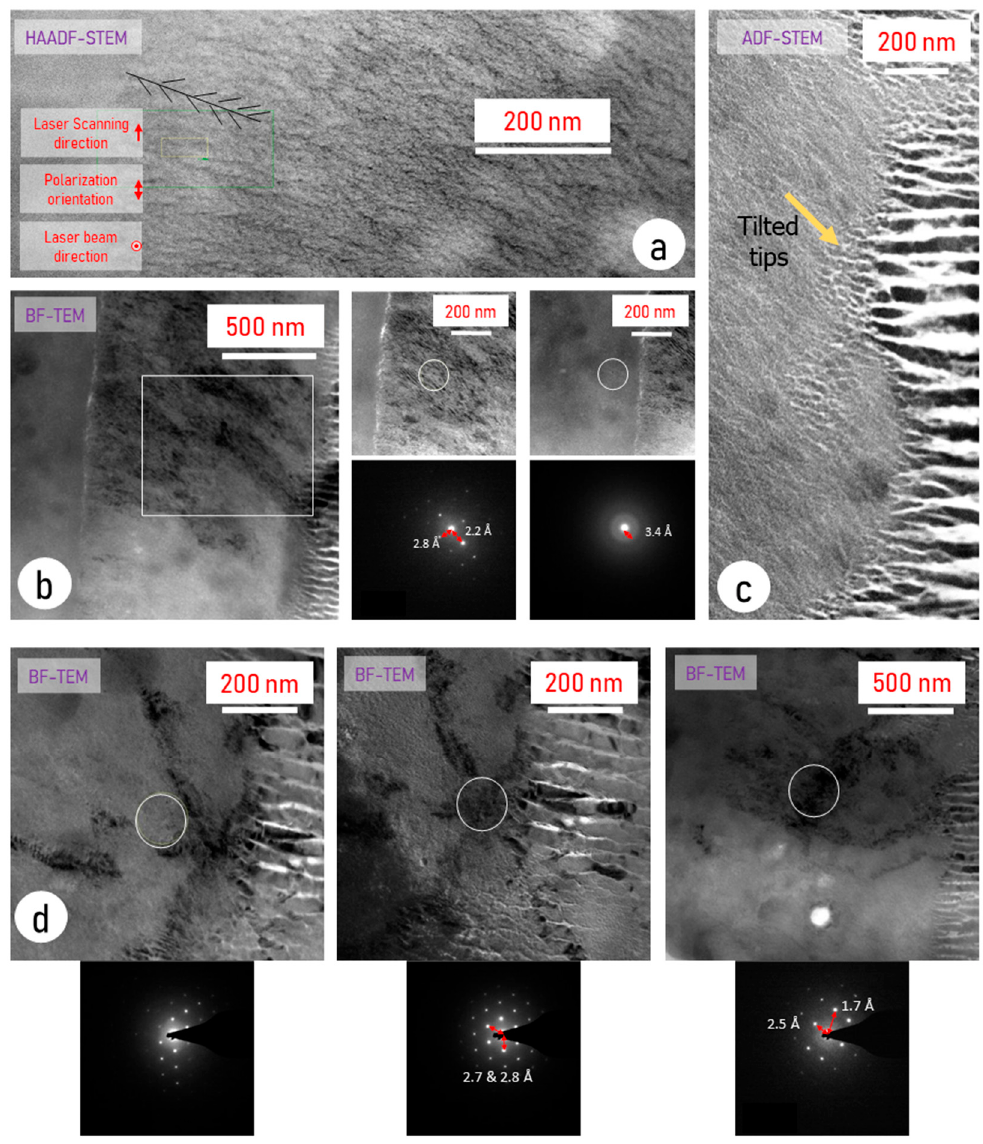
Figure 3. ( a ) HAADF-STEM of area 2 and out of bouquet structures, ( b ) BF-TEM and diffraction patterns of both areas 2 and 1 inside the region of the bouquet, ( c ) ADF-STEM at the interface between areas 2 and 3, and ( d ) BF-TEM and diffraction patterns in area 2, between dark and brighter regions The reference frame (laser scanning direction, polarization orientation, etc., is identical to Figure 2).